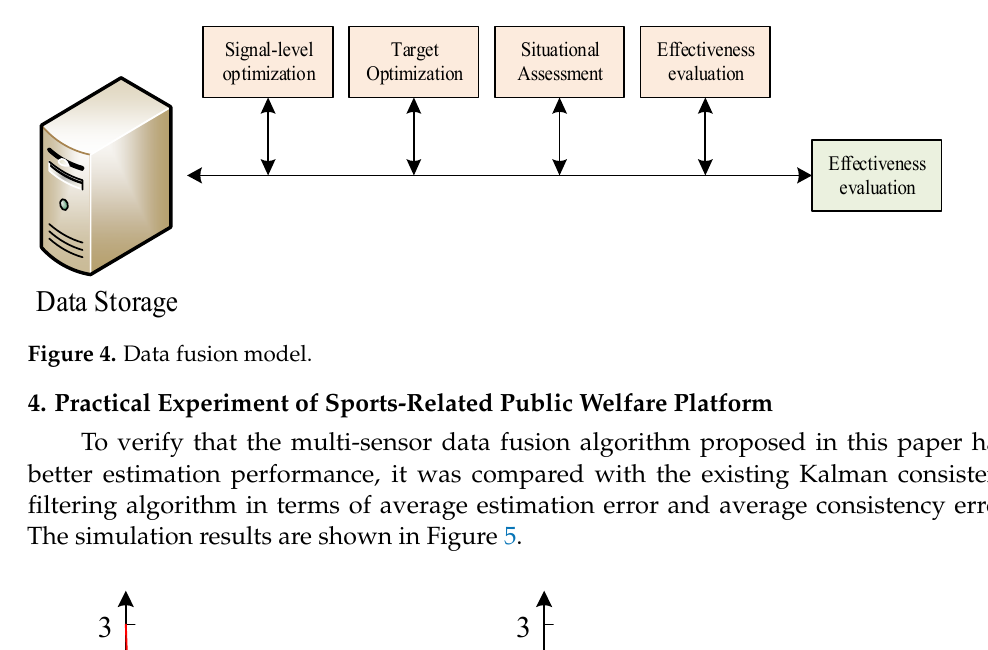
Algorithm of this paperExisting Algorithms